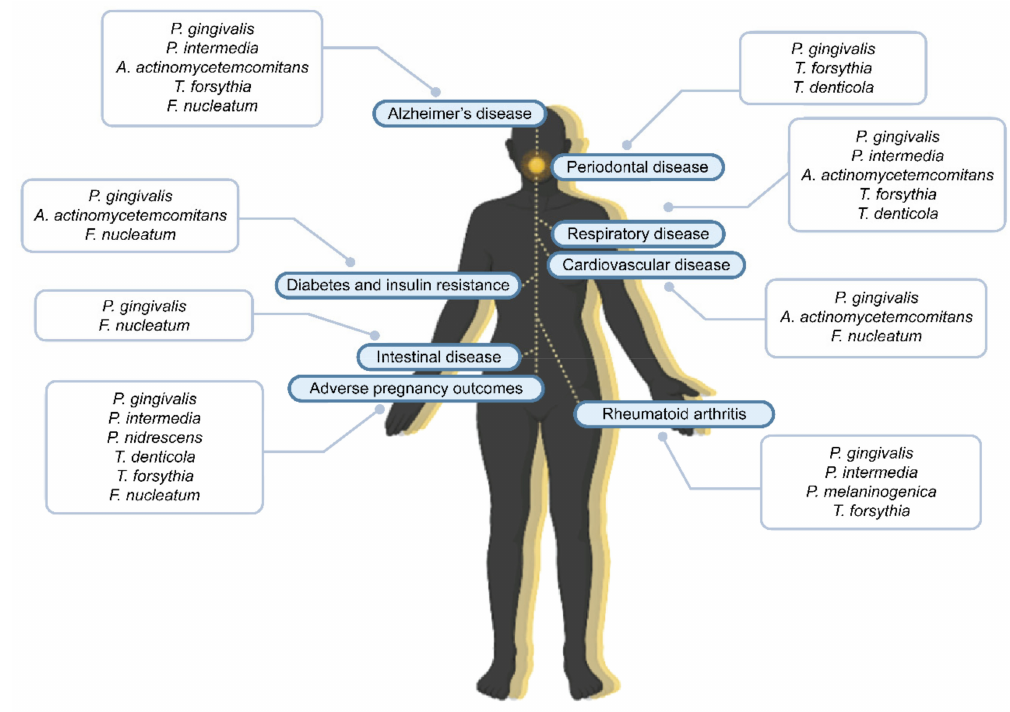
Figure 3. Schematic representation of different systemic diseases and their association with oral keystone pathogens. (Created with BioRender.com accessed on 27 April